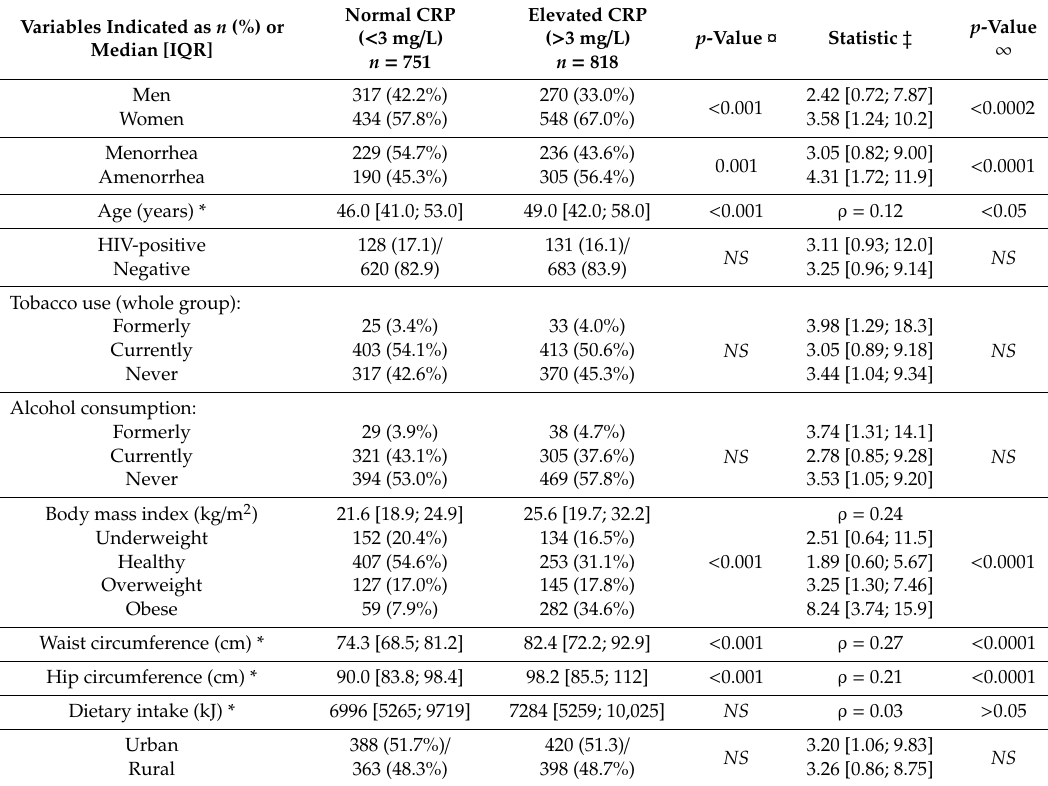
Table 1. Demographic characteristics of the study